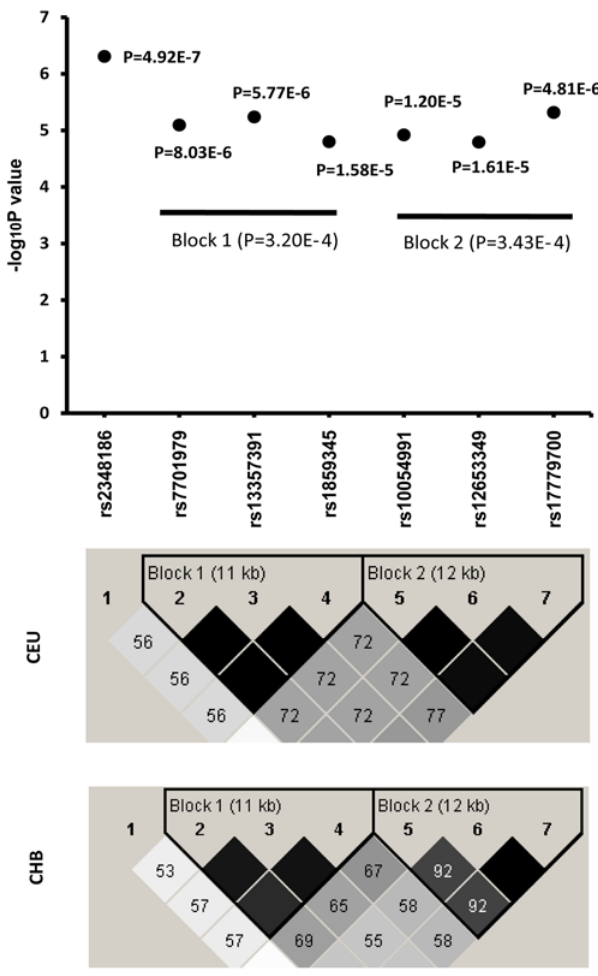
Figure 2. Association signals of the seven most significant SNPs of the SPOCK gene. This figure illustrates the association signals in our GWAS for the seven SPOCK gene SNPs that achieved significant genome-wide FDR values ( q , 0.05). The figure also shows the signals for two haplotype blocks (Blocks 1 & 2) formed by the SNPs rs7701979 , rs13357391 and rs1859345 (for Block 1) and the SNPs rs10054991 , rs12653349 and rs17779700 (for Block 2). The haplotype block map for the seven SPOCK gene SNPs, showing pairwise LD in D 9 , was constructed for both Caucasians (CEU) and Chinese Han (CHB) using the Haploview program [54] (http://www.broad.mit.edu/mpg/haplo- view/) and the most recent SNP genotype data (HapMap Data Rel 26/ phaseIII Nov 08, on NCBI B36 assembly, dbSNP b126) from HapMap (www.hapmap.org).